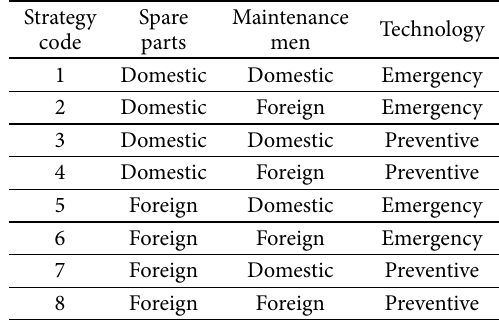
Table 1. Possible maintenance alternatives Strategy